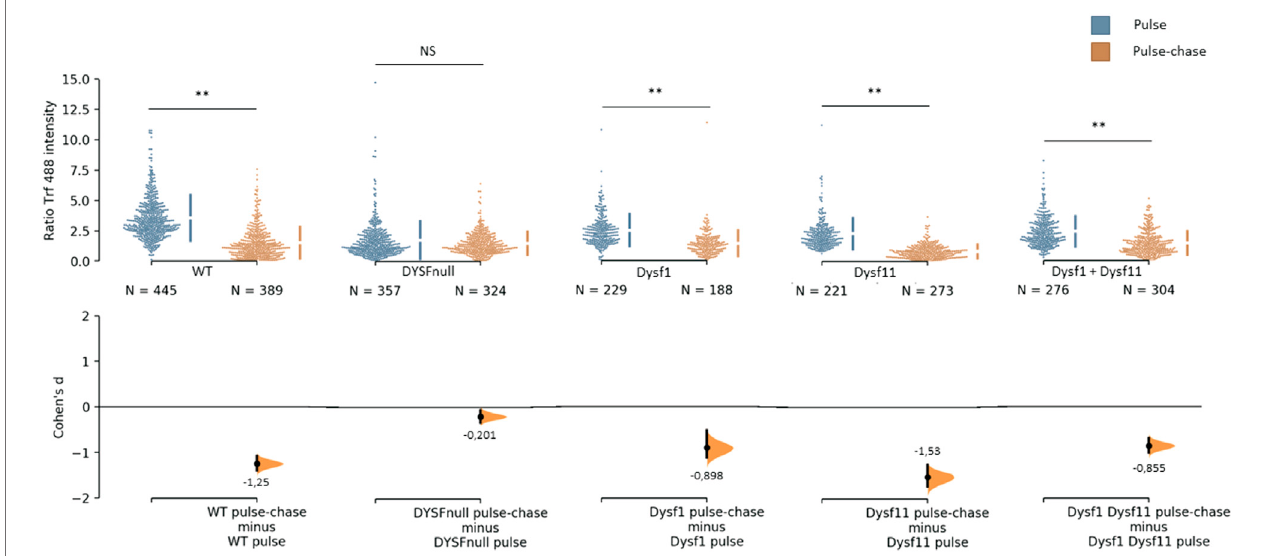
FIGURE 5 | Dysferlin 11 transcript participates in protein vesicle traf fi cking. Transferrin assay performed on control human myoblasts (WT, C25), dysferlin-null human myoblasts (DYSF-null, AB320) and transfected dysferlin-null human myoblasts (DYSF-null + mCherry-dysferlin1, DYSF-null + mCherry-dysferlin11, DYSF-null + mCherry-dysferlin1+mCherry-dysferlin11).Myoblastswereincubatedfor30 minwithtransferrincoupledwithAlexaFluor488(pulse)andfor30 minwithtransferrin-free medium (pulse-chase). For each condition, transferrin intensity was measured in more than 180 cells observed in three independent experiments. Statistical analysis was performed using Mann-Whitney test (NS: non-signi fi cant, *: p -value < 0.05, **: p -value < 0.01) and the Cohen ’ s coef fi cient is presented below each graph.